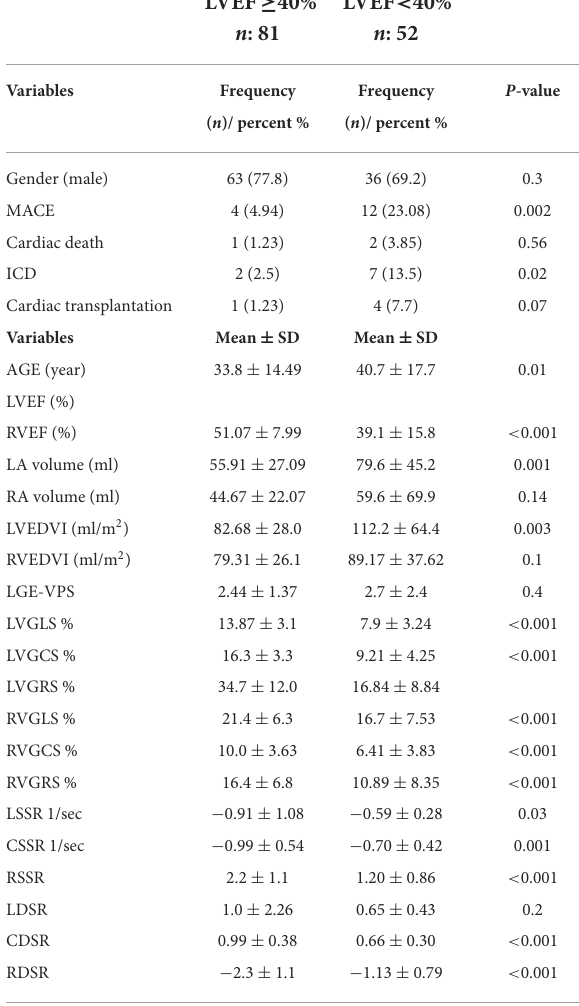
TABLE 1 Demographic and baseline CMR parameters of the study population.